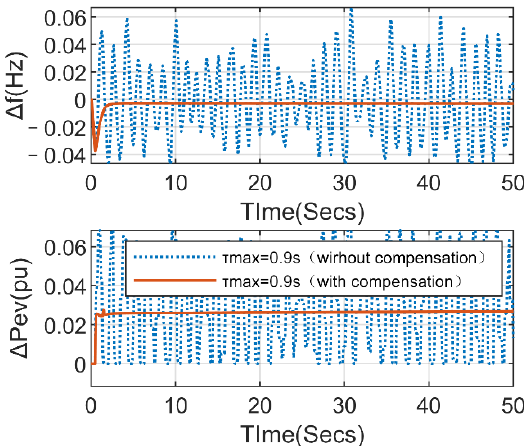
Figure 10. τ max = 0.2 s with or without predictive compensation of the system dynamic response.